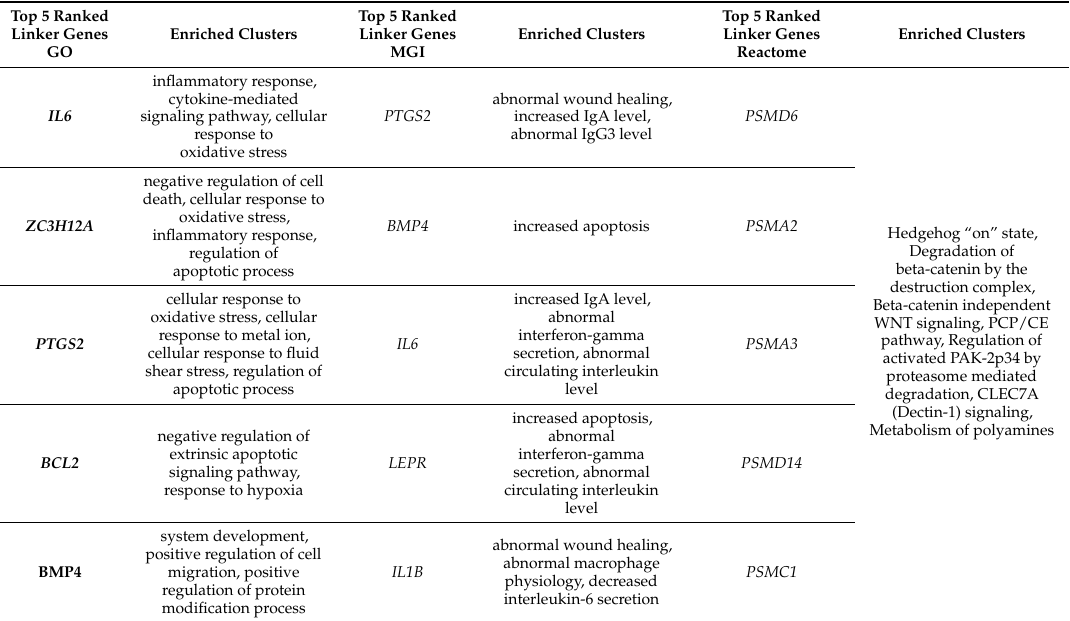
Table 9. Top 5 Ranked Linker Genes resulting from ranked aggregation from Linker gene lists for bystander vs. control comparisons of datasets GSE18760, GSE12435, and GSE8993. Top enriched clusters are illustrated for each Linker